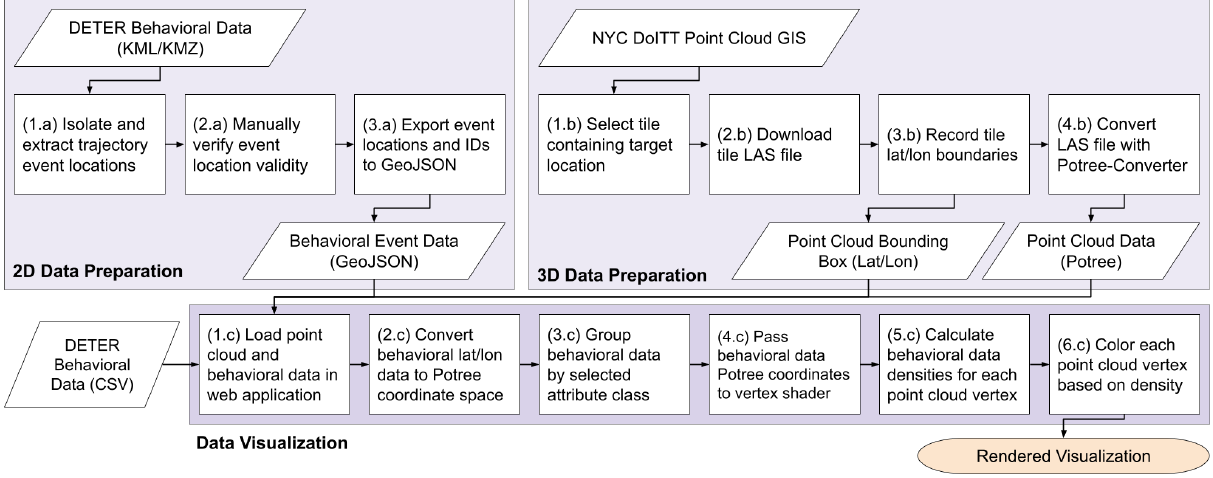
Figure 1. Process of data preparation and